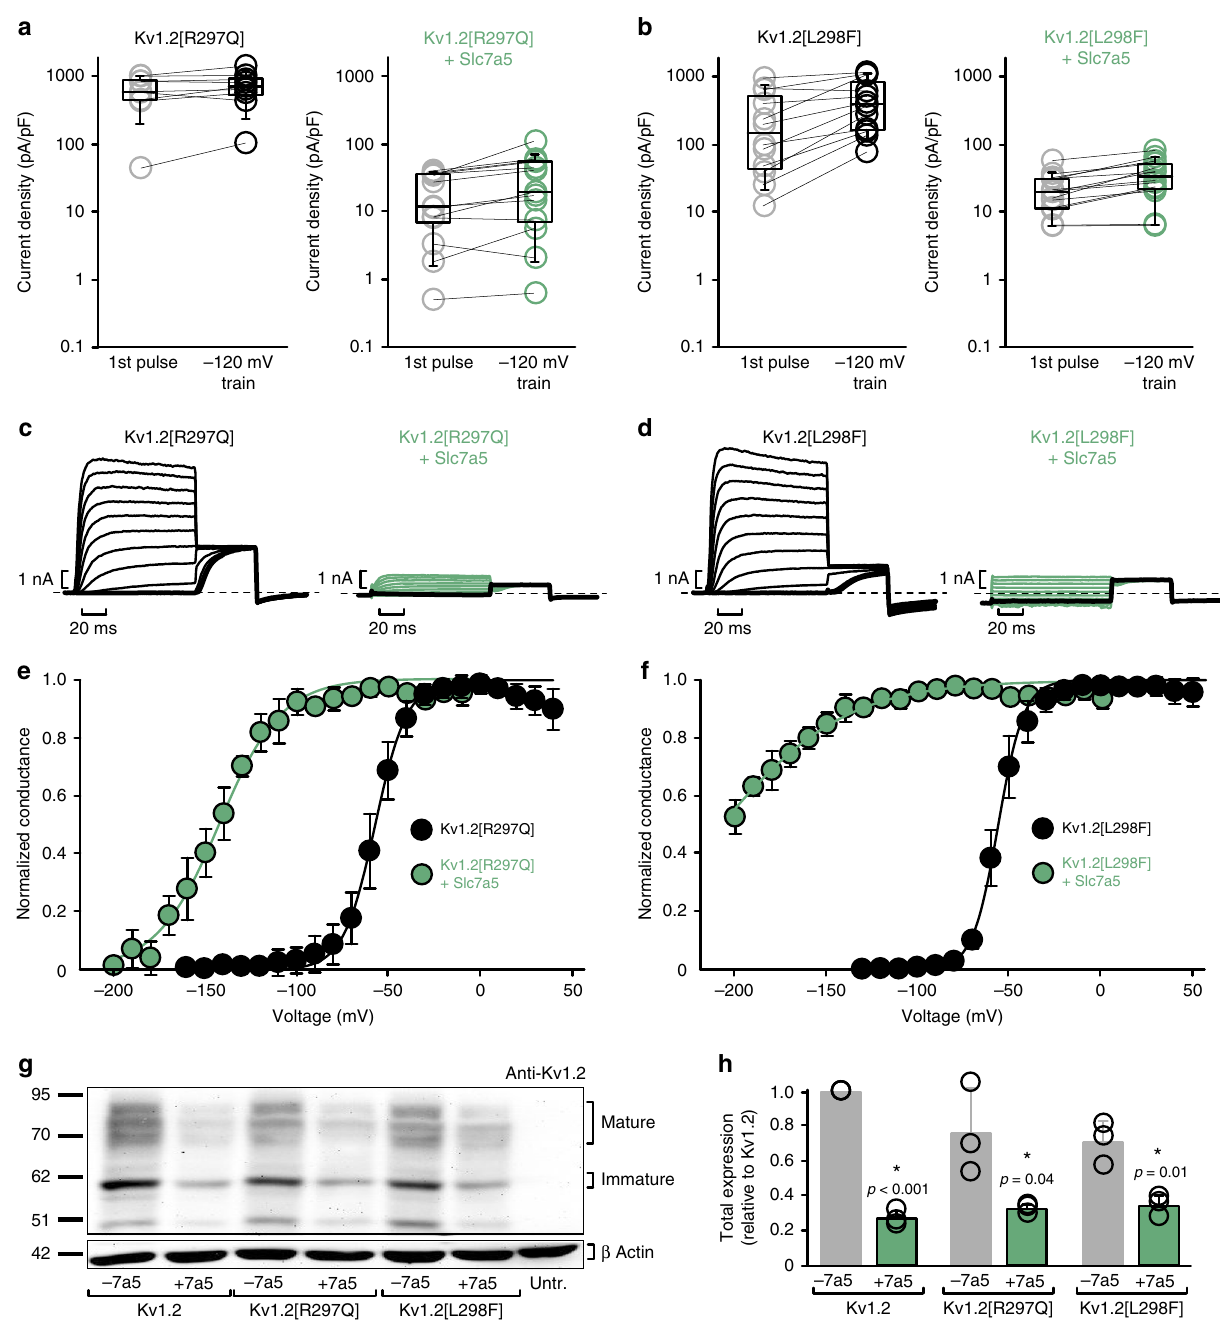
Fig. 9 Kv1.2 disease-linked mutations are strongly suppressed by Slc7a5. a , b Current density at + 60 mV was measured before and after a 30 s hyperpolarizing train to − 120 mV for Kv1.2[R297Q] alone ( n = 6) or with Slc7a5 ( n = 13), and Kv1.2[L298F] alone ( n = 12) or with Slc7a5 ( n = 14), as indicated. c , d Exemplar currents recorded from Kv1.2[R297Q] or Kv1.2[L298F], expressed in ltk- mouse fi broblasts. Highlighted sweeps are to − 120 mV with a tail current voltage of − 30 mV. e , f Conductance-voltage relationships for Kv1.2[R297Q] ( V 1/2 = − 57 ± 4 mV, k = 8 ± 1 mV, n = 6) and Kv1.2 [R297Q] + Slc7a5 (2:1 transfection, V 1/2 = − 143 ± 6 mV, k = 17 ± 2 mV, n = 9), Kv1.2[L298F] ( V 1/2 = − 56 ± 1 mV, 7 ± 1 mV, n = 4) and Kv1.2[L298F] + Slc7a5 (4:1 transfection, V 1/2 < − 200 mV, estimated to be − 210 ± 5 mV, k = 35 ± 6 mV, n = 9). g Exemplar western blot of cell lysates from ltk- mouse fi broblasts transfected with indicated combinations of Kv1.2 mutants and Slc7a5 as indicated, each at a 1:1 transfection ratio. h Densitometric quanti fi cation of Slc7a5 effects on total protein levels of various Kv1.2 mutants (data shown as mean ± s.d., n = 3 per condition); Student ’ s t -test was used to compare expression of each mutant in the presence and absence of